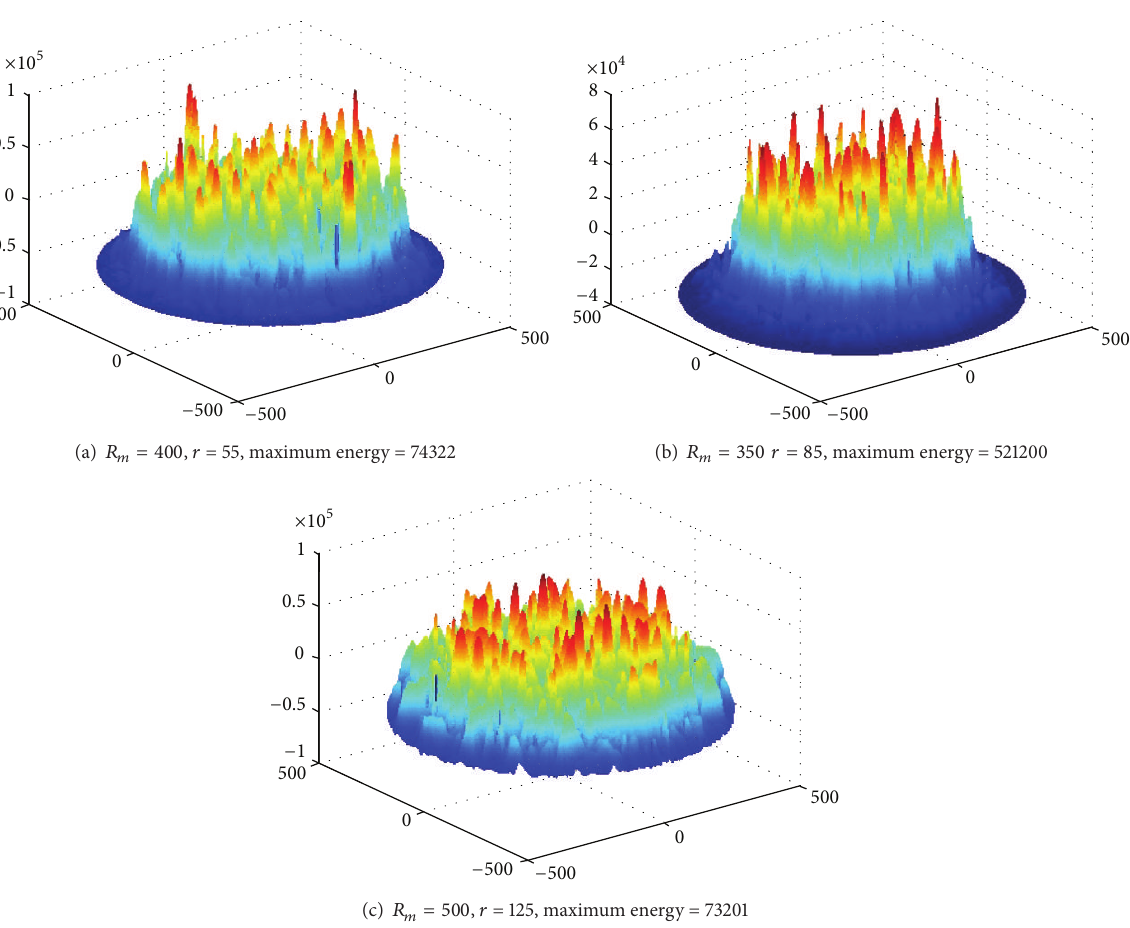
Figure 29: Energy consumption under different transmission range (experimental value, 𝑅 = 500 , rounds = 20, anchors = 20).